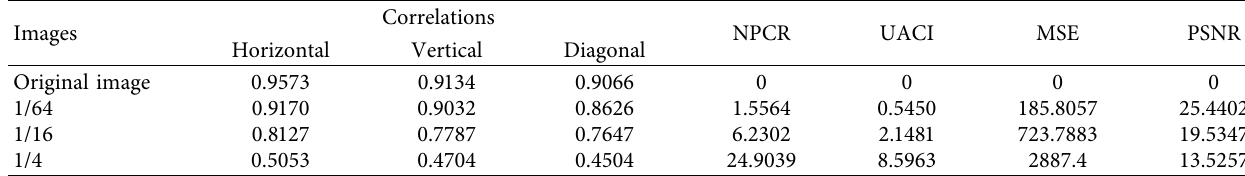
Figure 9: The cipher images and their decrypted images after data loss attacks. (a) 1/64 occlusion. (b) 1/16 occlusion. (c) 1/4 occlusion. (d) Decrypted image with 1/64 occlusion. (e) Decrypted image with 1/16 occlusion. (f) Decrypted image with 1/4 occlusion. Table 10: The indicators of decrypted cameraman images after data loss attacks.